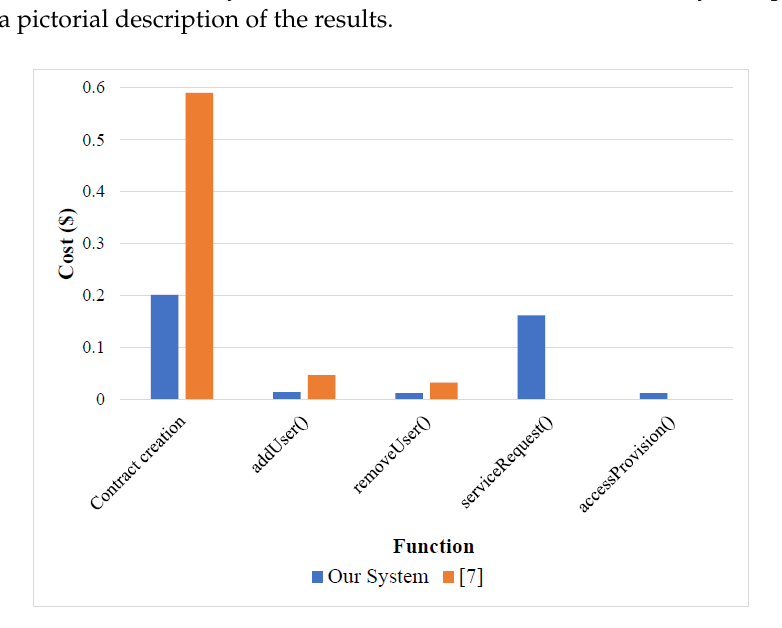
Figure 4. Smart contract function